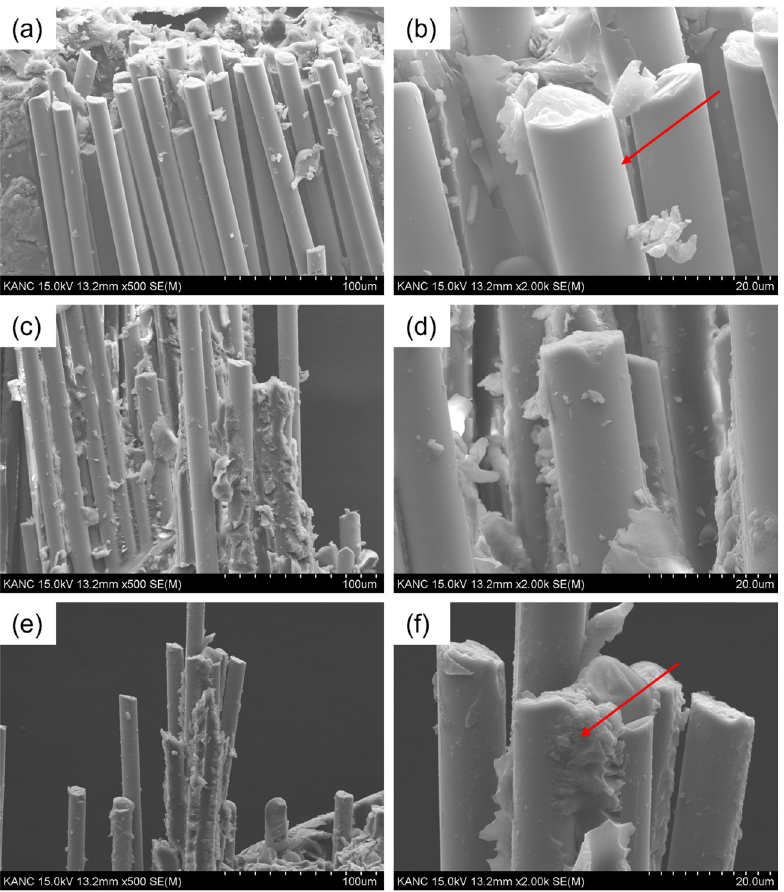
Figure 6: FE - SEM image of the fracture surface of ( a and b ) basalt/epoxy, ( c and d ) GO + epoxy/basalt, and ( e and f ) rGO@Basalt/epoxy composites.